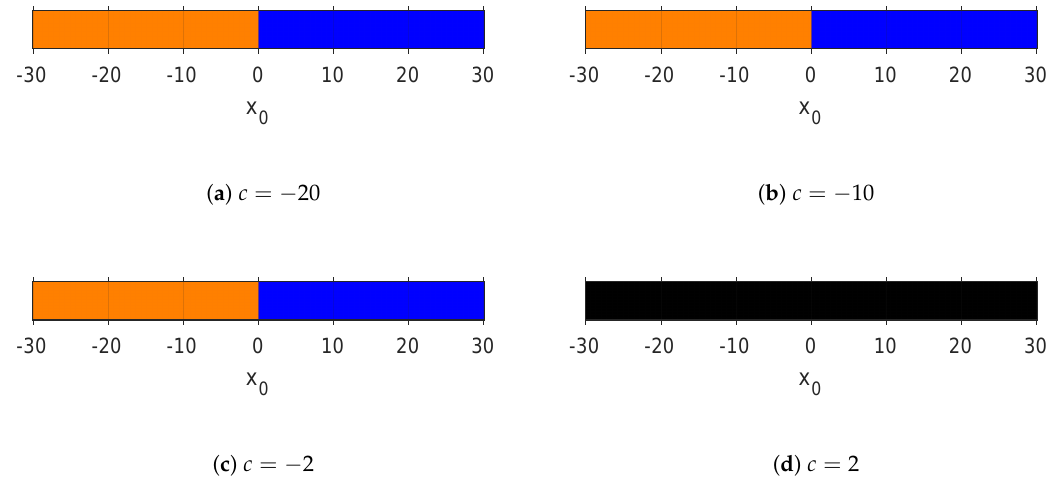
Figure 6. Dynamical lines of TM2 method on p c ( x ) = x 2 + c for different values of c . Color basins: ( c ) orange, x F ( c ) blue, no convergent points in black. x F 2 1